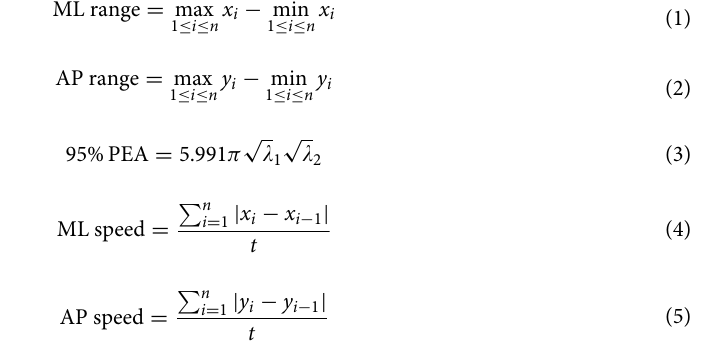
to be eliminated as a potential error source. The remaining data was then treated with a moving average filter of 15 frames to reduce the effects of extrinsic or intrinsic noise. The processed data was then used to calculate the sway parameters of the subjects during the balance trials. The sway parameters assessed included the sway amplitude in the mediolateral (ML) and anterioposterior (AP) directions, swept area, and mean sway speeds in the ML and AP directions of the subjects 35 . ML and AP sway ranges were calculated via the amplitudes (ranges) of the subject sway along the frontal and sagittal planes respectively (Eqs .1, 2). Swept area was calculated using the area of the 95% prediction ellipse (PEA) (Eq. 3), defined as the ellipse containing 95% of the points in the subject’s stabilogram. Mean sway speeds in the ML and AP directions were calculated by dividing the total path length of the COP or marker along the frontal or sagittal planes respectively by the total trial time 36 (Eqs. 4, 5). The formulae used in the sway param- eters calculation are listed below for a stabilogram of time duration t containing a set of n data points ( x i , y i ) with eigenvalues of (cid:31) 1 and (cid:31) 2 from the co-variance matrix of the data.